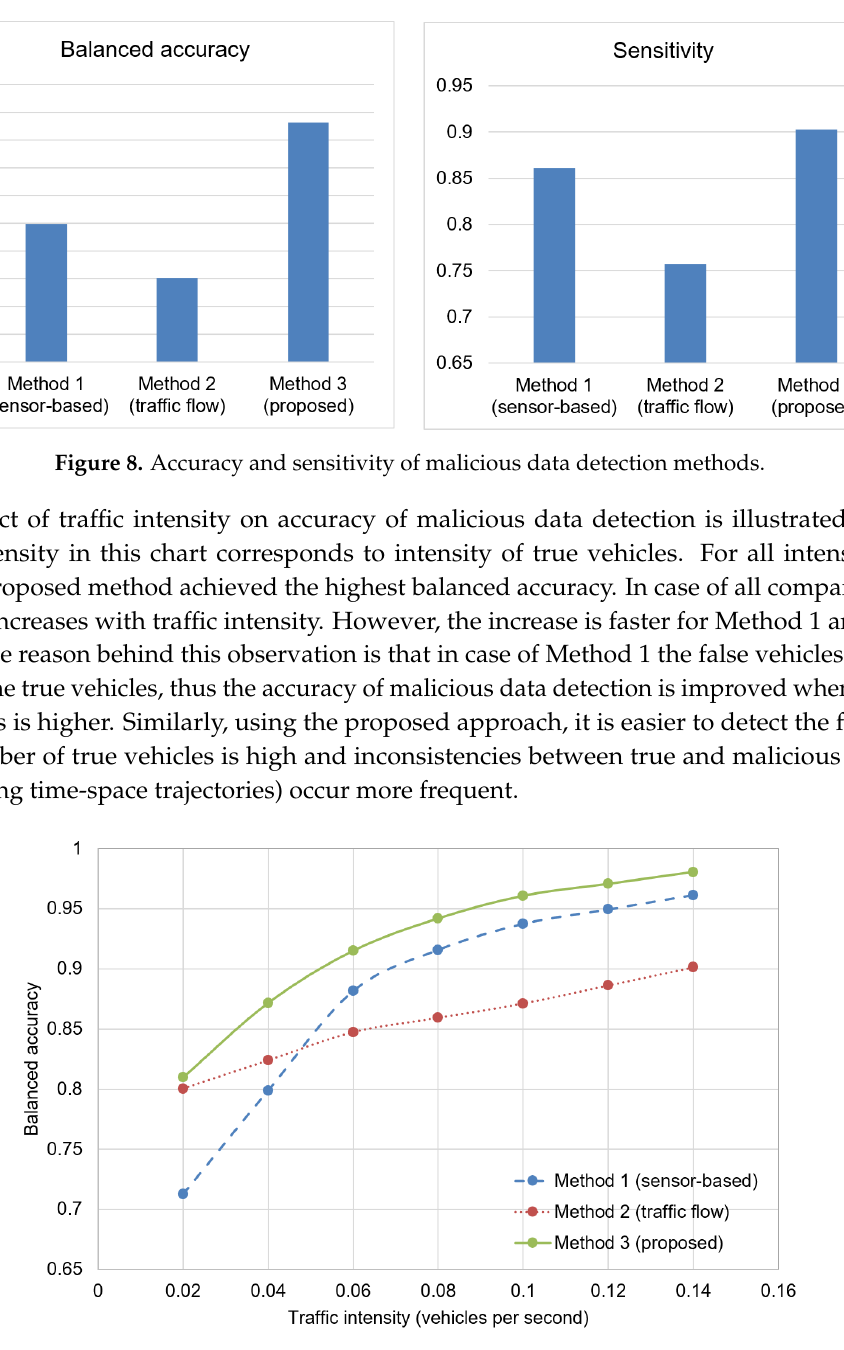
Figure 9. Accuracy of malicious data detection for different traffic